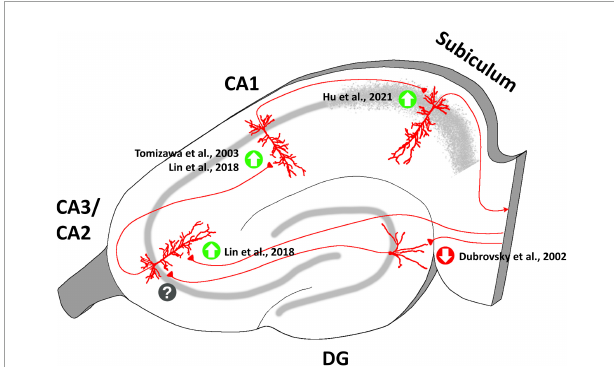
FIGURE5 Oxytocinergic modulations of the synaptic plasticity at the different regions of the rodent’s hippocampus. OT plays a crucial role in mediating long-term plasticity at the hippocampal synapses exerting different effects in each specific hippocampal region (enhancement of long-term potentiation = green upward arrow; emergence of long-term depression = red downward arrow; unknow OT effect on plasticity = question mark). The figure shows the main bibliographic references in which the OT-dependent modulations of synaptic plasticity in the specific regions of the hippocampus have been